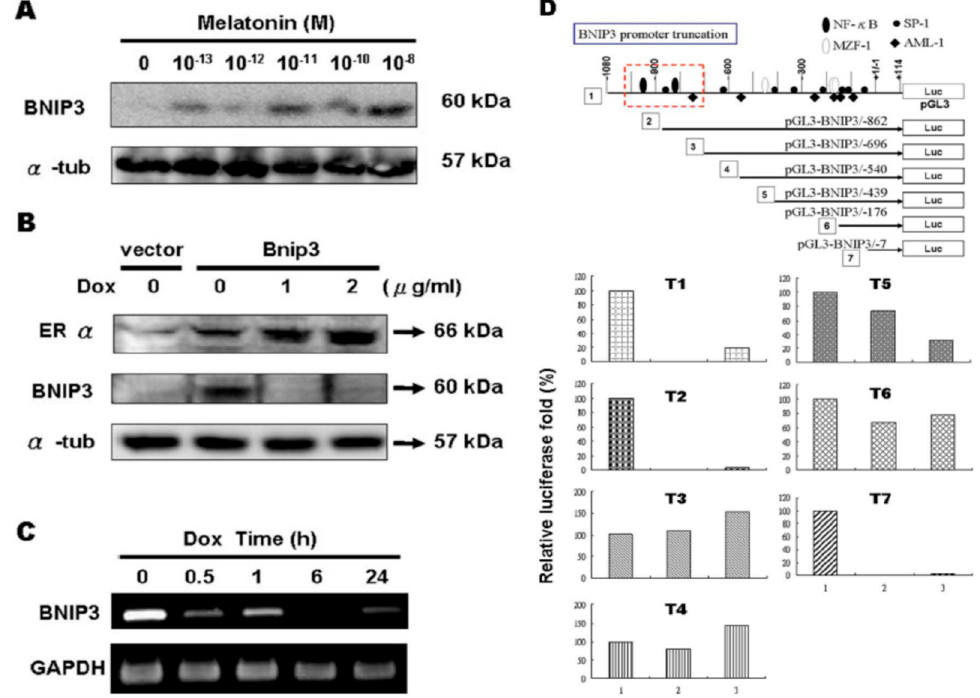
Figure 5. ER α /E2 inhibited BNIP3 mRNA and protein expression. ( A ) H9c2 cells were treated with indicated concentrations of melatonin in serum-free medium for 24 h. The level of BNIP3 protein increased in a concentration-dependent manner; ( B ) Tet-on ER α H9c2 cells were transfected with BNIP3 (6 μ g), incubated for 6 h, and were then exposed to doxycycline (0, 1, 2 μ g/mL) in serum-free medium for 18 h. Proteins were then extracted for Western blot analysis. The protein level of BNIP3 decreased in an ER α -dependent manner; ( C ) We found a time-dependent relationship between BNIP3 and ER α . The time course of exposure of doxycycline showed repression of BNIP3 mRNA transcripts; ( D ) Luciferase assay showed the exposure of ER α and/or E2 with pGL3-BNIP3 presented nearly 100% repression of BNIP3 luminescence (T1, T2 and T7). Bar 1: pGL3-T, Bar 2: pGL3-T+ER α , Bar 3: pGL3-T+ER α +E2, T1–T7: BNIP3 promoter truncation 1–7.